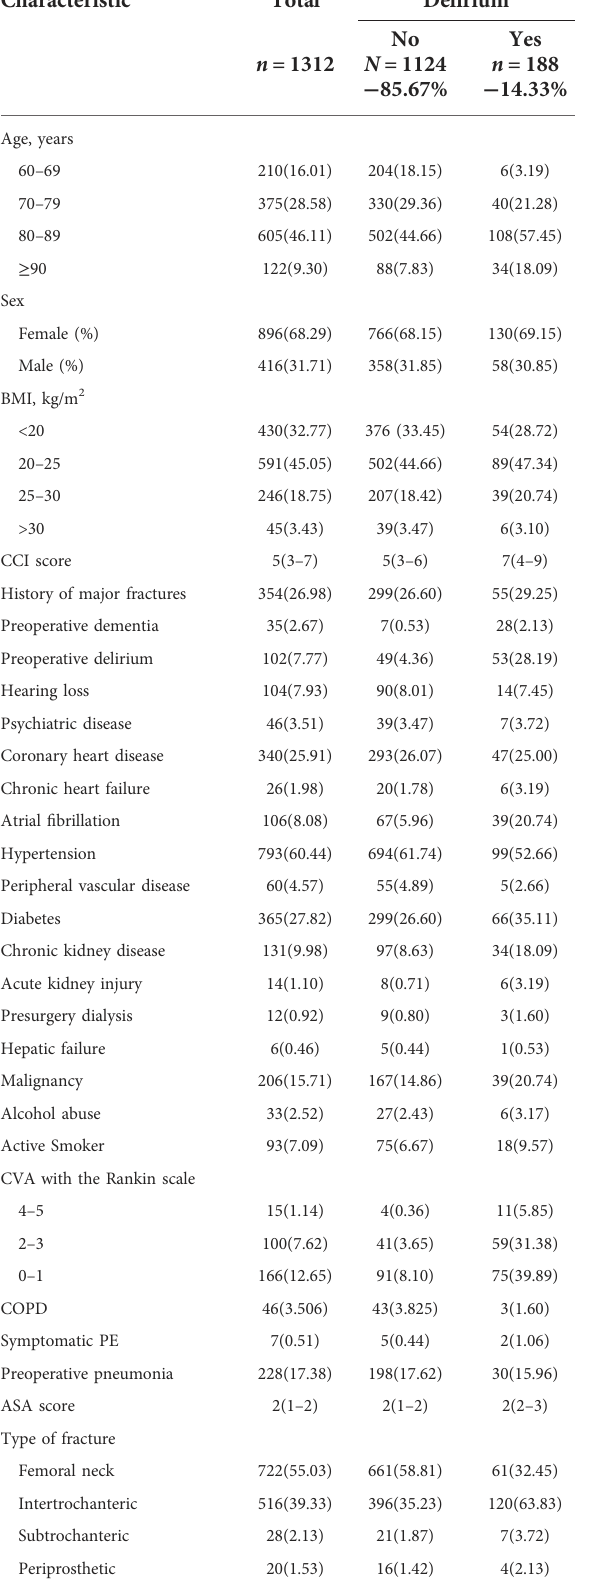
TABLE 1 Baseline characteristics of patients in the derivation cohort who did or did not develop postoperative delirium.